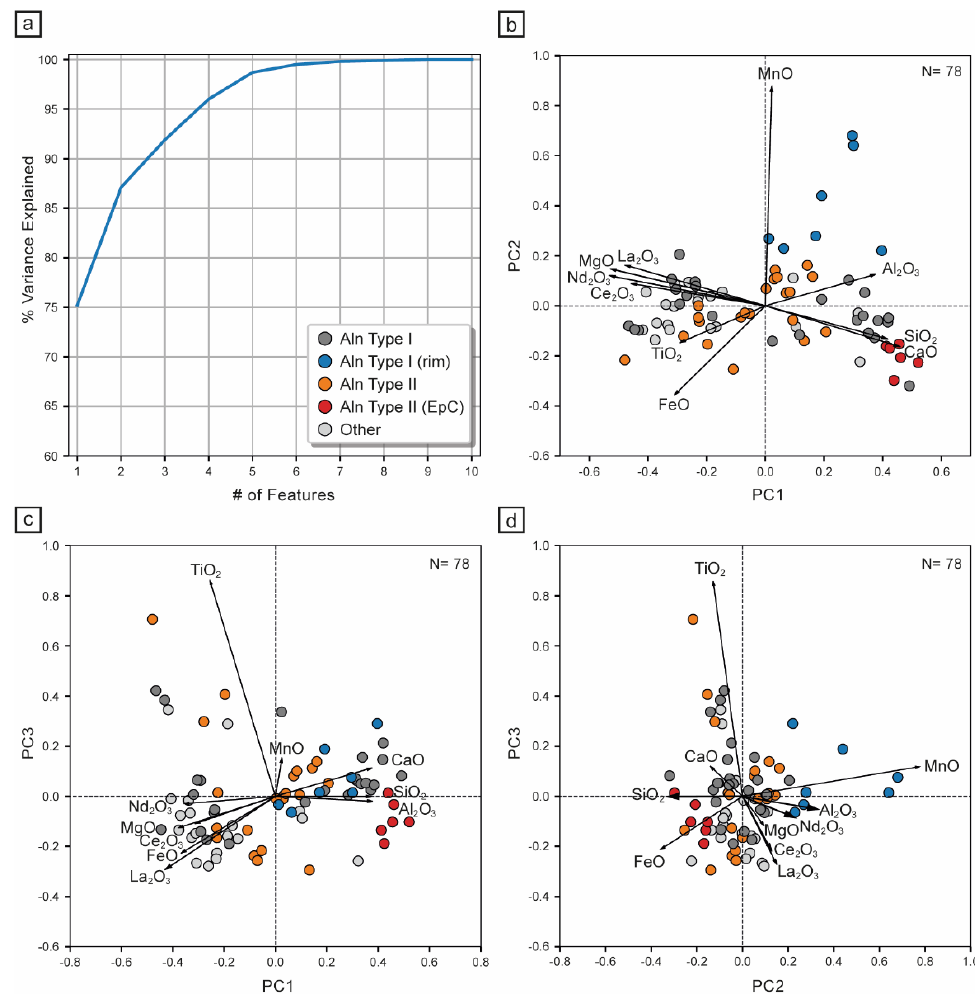
Figure 5. Principal component analysis of 10 major oxides using microprobe geochemical data. ( a ) Cumulative explained variance of the 10 principal components. A total of 91.9% of the variance is explained by the first three out of the 10 components. ( b – d ) correspond to binary plots of the three main principal components. ( b ) PC1 vs. PC2; ( c ) PC1 vs. PC3; ( d ) PC2 vs. PC3. The compositional vector of each major oxide is projected into principal components coordinates for easy visualization of the main patterns. N = number of point analyses considered.